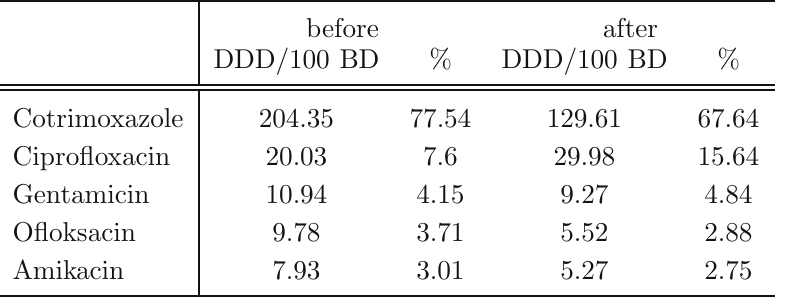
Table 4 Five most commonly used antiinfective agents at the urology ward in decreasing